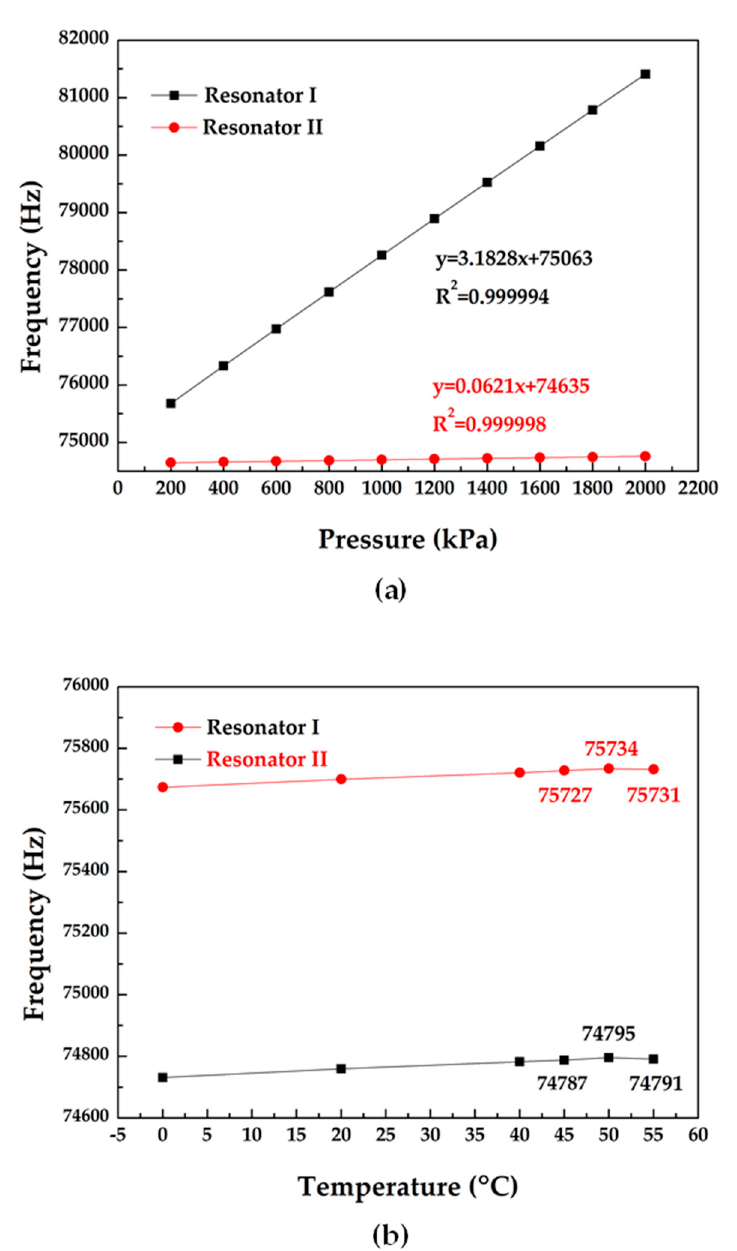
Figure 2. ( a ) the intrinsic frequency responses to applied pressure in the room temperature and ( b ) the intrinsic frequency responses to surrounding temperature at 200 kPa.